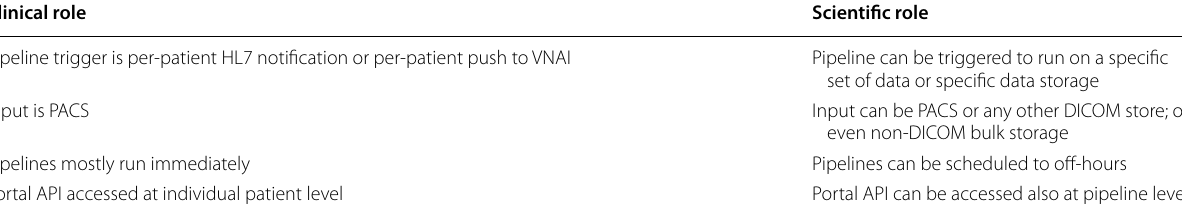
Table 1 Differences between clinical and scientific user roles of VNAI Clinical